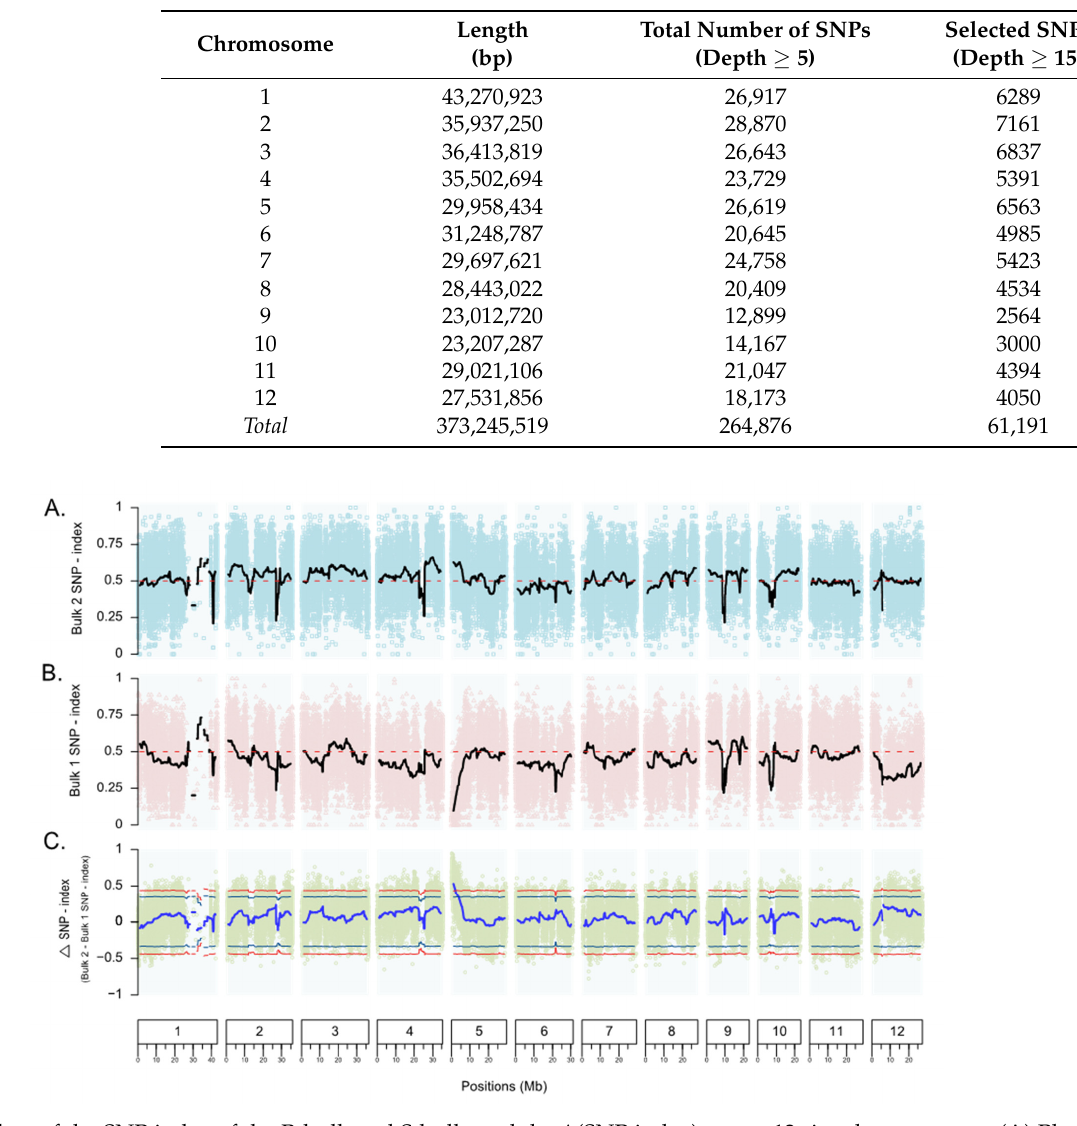
Figure 2. Plots of the SNP index of the R-bulk and S-bulk, and the ∆ (SNP index) across 12 rice chromosomes. ( A ) Plots of the SNP index in the S-bulk (blue dots). ( B ) Plots of the SNP index in the R-bulk (pink dots). ( C ) Plots of the ∆ (SNP index). Sliding window plots of the average SNP index with a window size of 1Mb and 10 kb increments are shown as black lines in ( A , B ) and as blue lines in ( C ). The green and red line pairs in ( C ) represent the 95% and 99% confidence intervals, respectively.